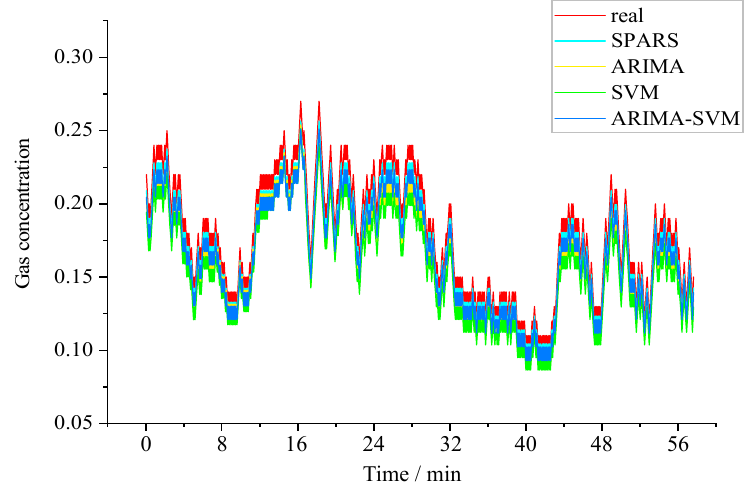
Figure 13. Changes in the RMSE of the model under different update cycles. Table 2. The overall value of the RMSE of the model under different update cycles.